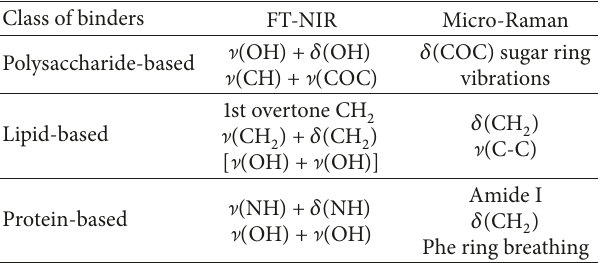
Table 2: Main near infrared and Raman bands, characteristic for different classes of binding media, highlighted by PCA applied on combined spectra referred to all neat